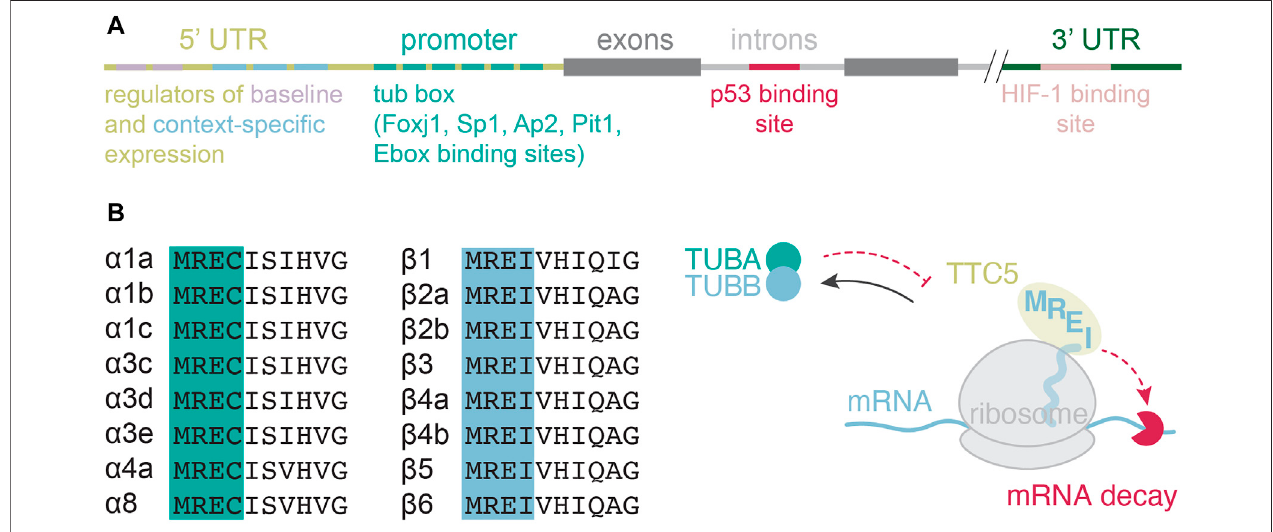
FIGURE 2 | Transcriptional and posttranscriptional regulation of tubulin gene expression. (A) Transcriptional regulatory elements mapped in various isotubulin genes and across species. (B) Amino-terminal protein sequence alignment of isotubulins and the current model for tubulin autoregulation.